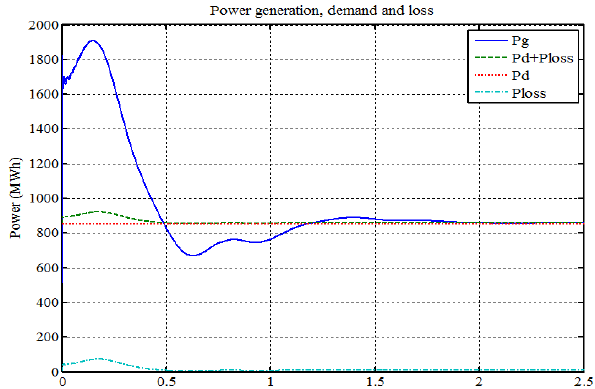
Figure 12. Case study 4: the power generation, power loss and power demand.